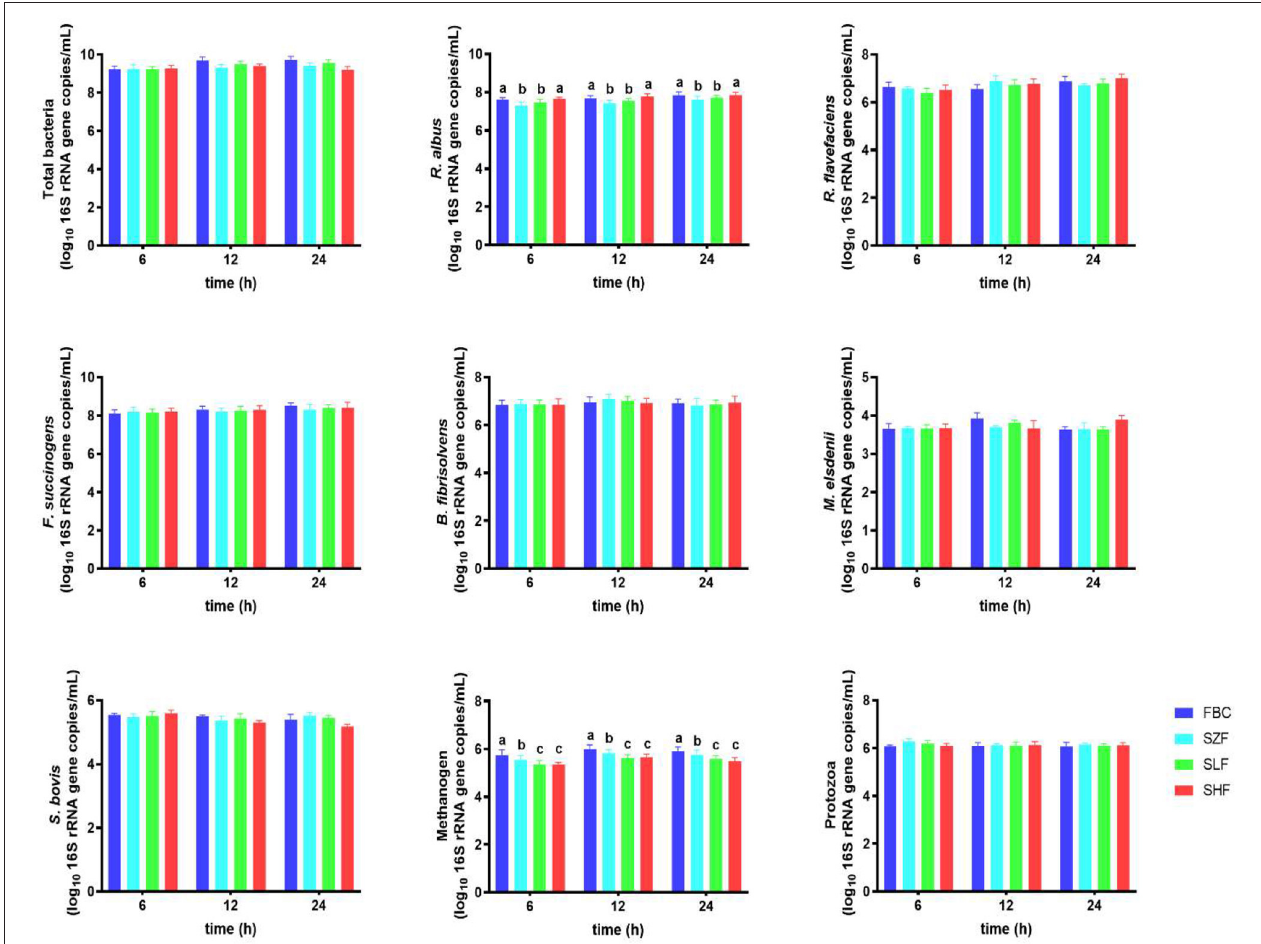
FIGURE 4 | Microbial population of black cane prior to ensiling (pre-ensiled materials) and silages treated with ferrous sulfate heptahydrate, at three time points (6, 12, 24h) during the in vitro rumen incubation (means ± SEM; n = 18). FBC, pre-ensiled materials; SZF, ensiled FBC + 0% ferrous sulfate heptahydrate; SLF, ensiled FBC + 0.015% ferrous sulfate heptahydrate; SHF, ensiled FBC + 0.030% ferrous sulfate heptahydrate. a − c A different superscript in similar sampling time indicates a significantly different mean ( P <